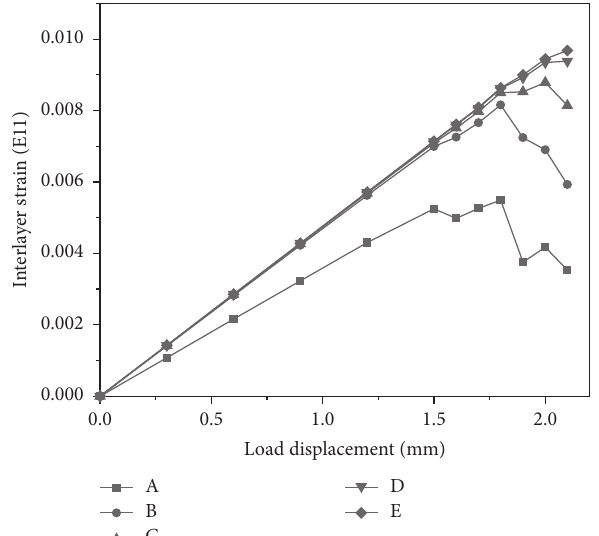
Figure 10: Curve graph of strain displacement.